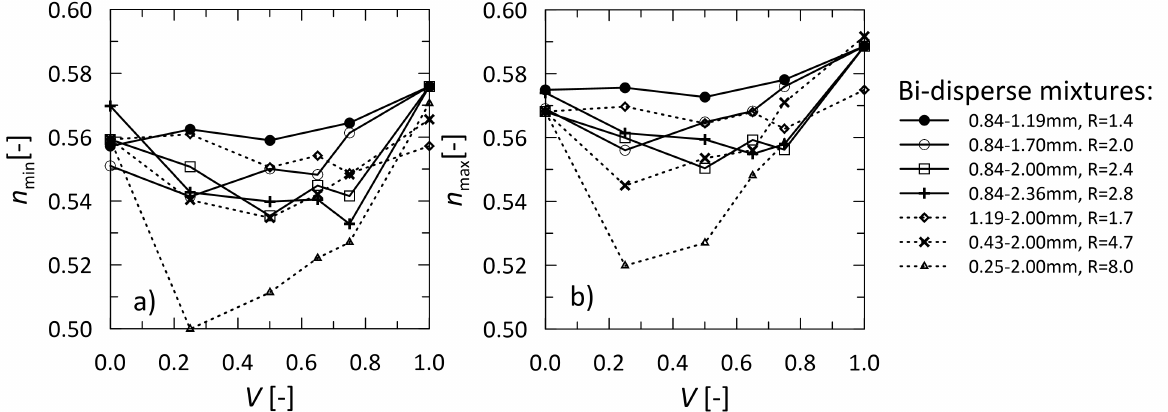
Figure 1. Measures of (a) minimum and (b) maximum void ratios for bi-disperse mixtures as a function of V , for di ff erent values of R .